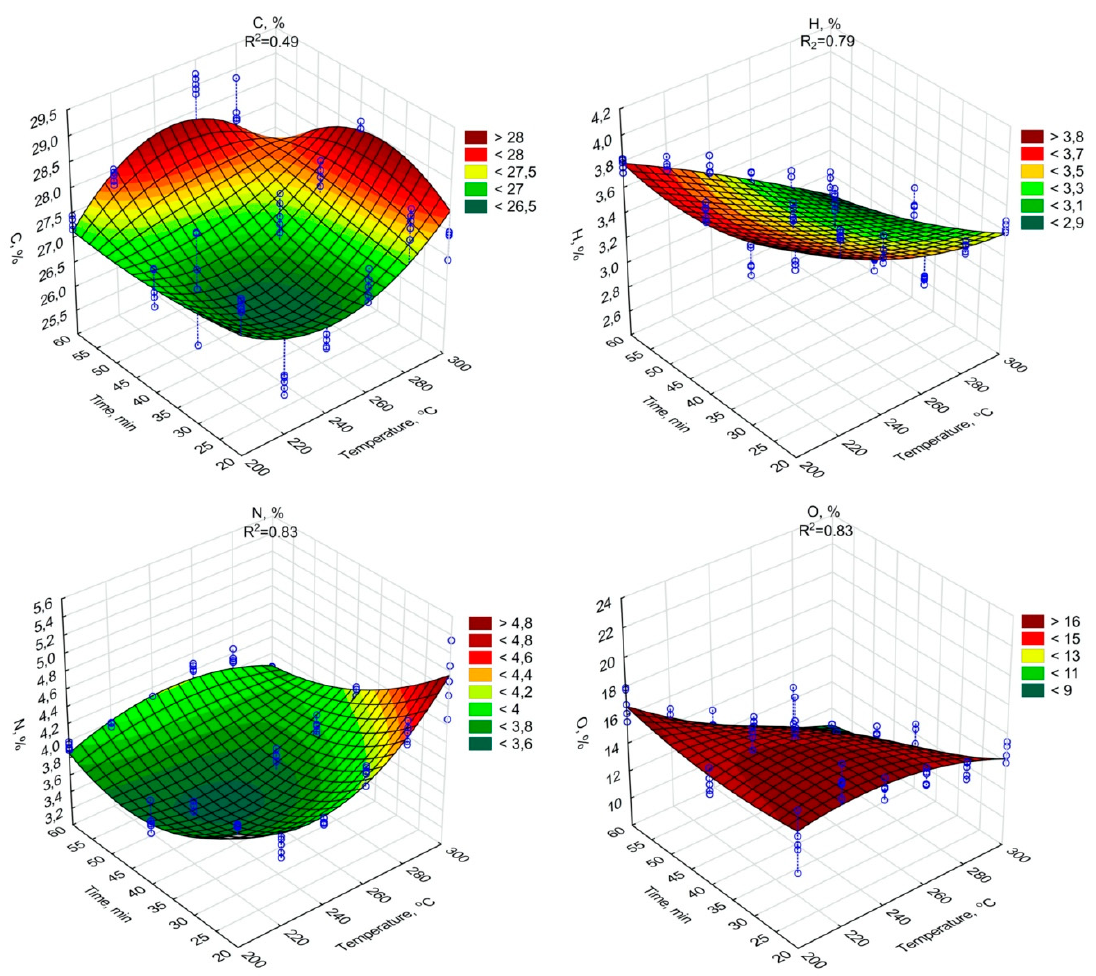
Figure 3. C, H, N, O percentage content in torrefied SS in relation to process temperature and residence time.